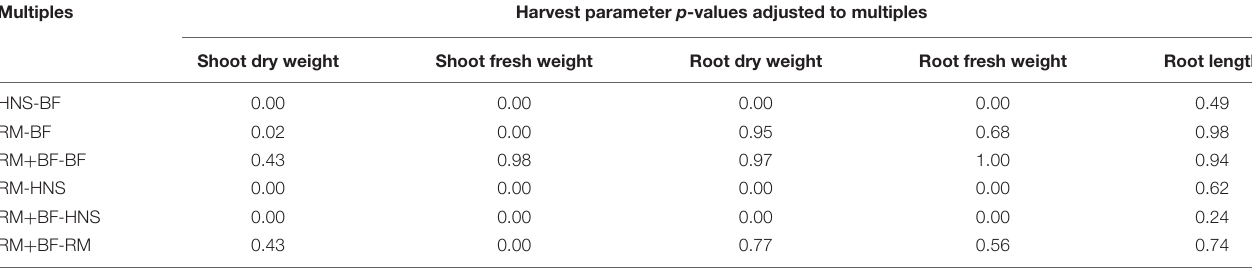
TABLE 2 | Tukey multiple pairwise-comparisons indicate that the hydroponic nutrient solution (HNS) crop was significantly different from other treatments in both shoot and root weights, although other treatments were more similar for certain metrics. Multiples Harvest parameter p -values adjusted to multiples Shoot dry